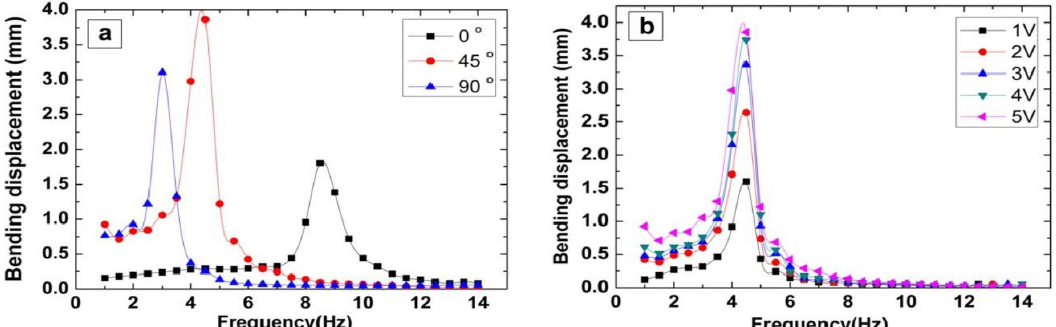
Figure 7. Bending displacement of piezo-paper actuator for different ( a ) orientation angles and ( b ) applied voltages. Young’s modulus varies with the orientation angle. Reprinted with permission from [61] c (cid:13) 2010,